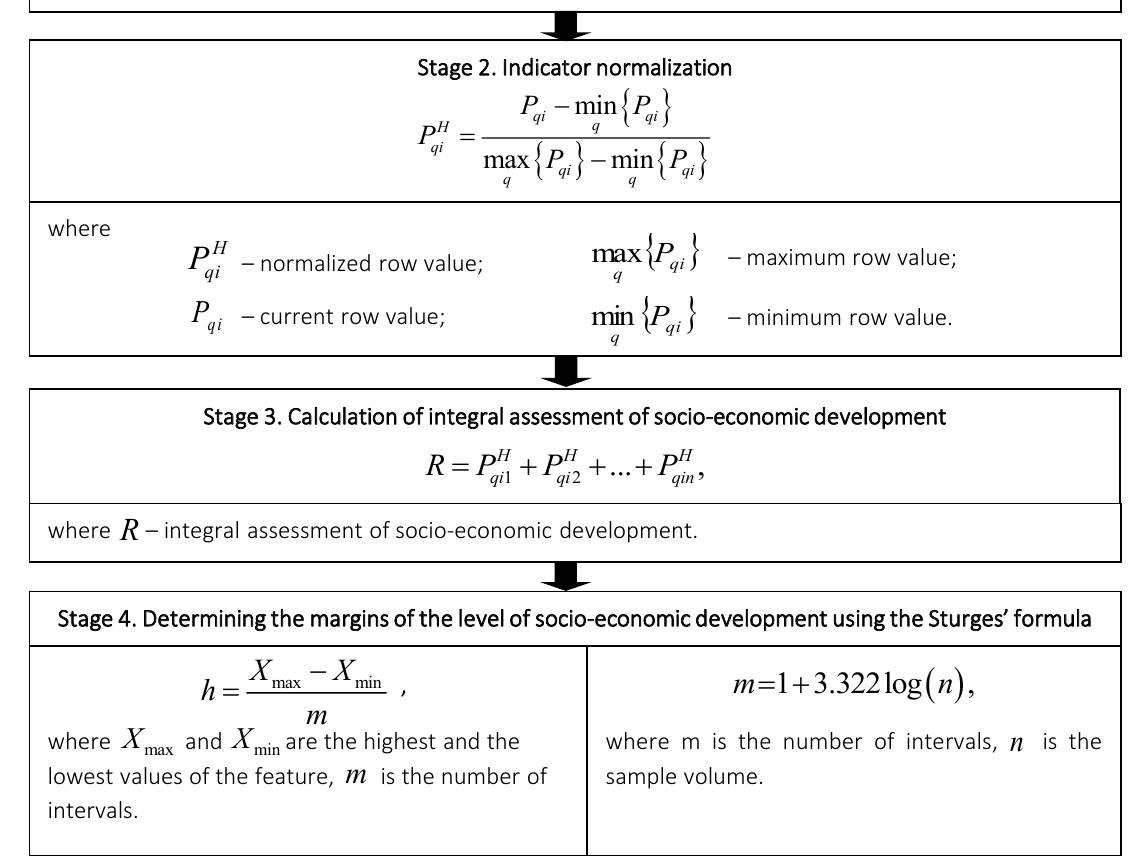
Figure 1. An algorithm for integral estimation of the socio-economic development of a region